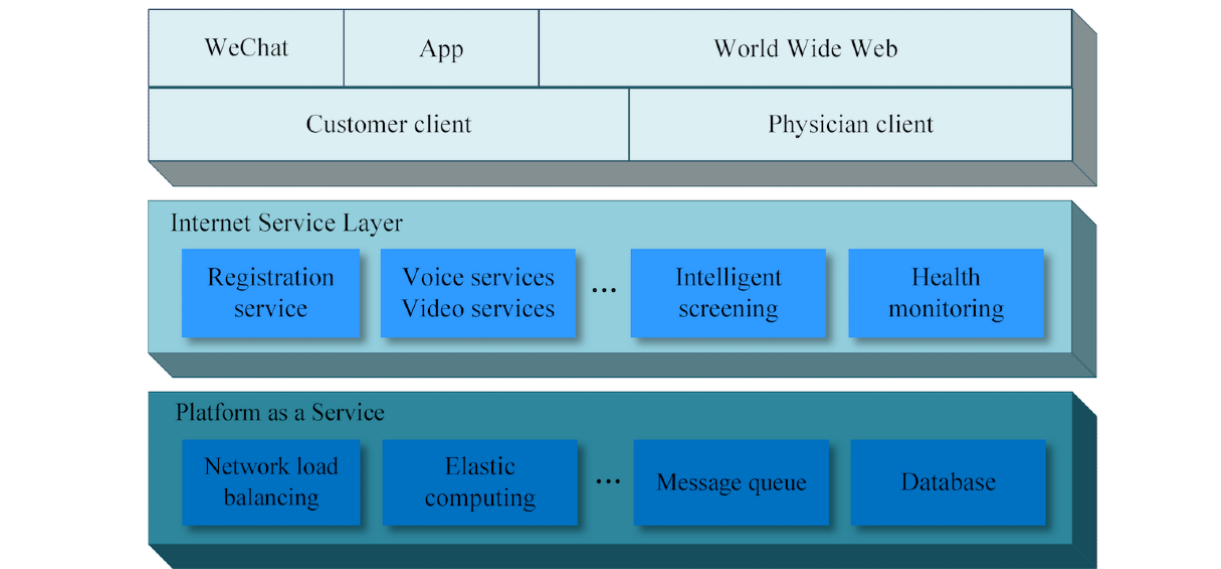
Figure 1. The web-based medical service